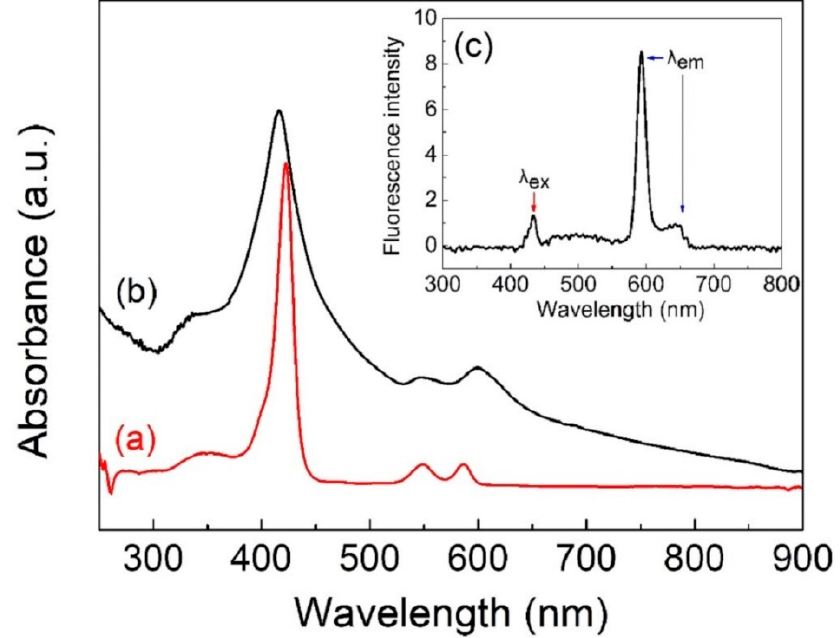
Figure 3. Ultraviolet/visible (UV/Vis) near- infrared (IR) spectra of ( a ) 156 ng/mL ZnPP/NMP solution and ( b ) ZnPP solid film; ( c ) photoluminescence (PL) spectrum of 2.43 ng/mL ZnPP/NMP solution.